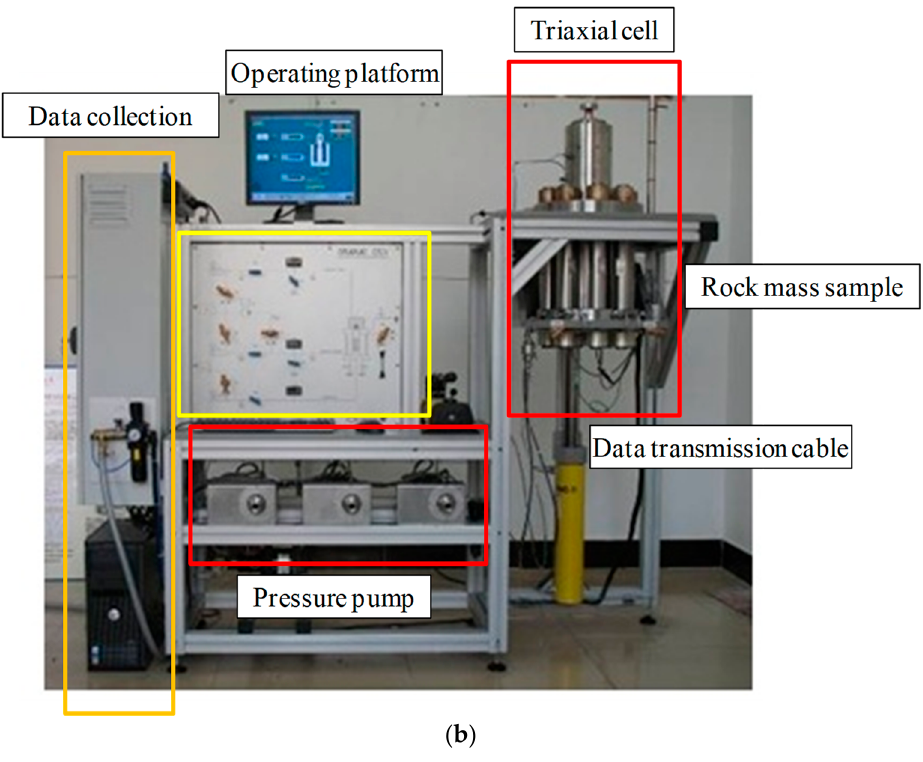
Figure 2. ( a ) Schematic diagram; ( b ) Experimental apparatus.